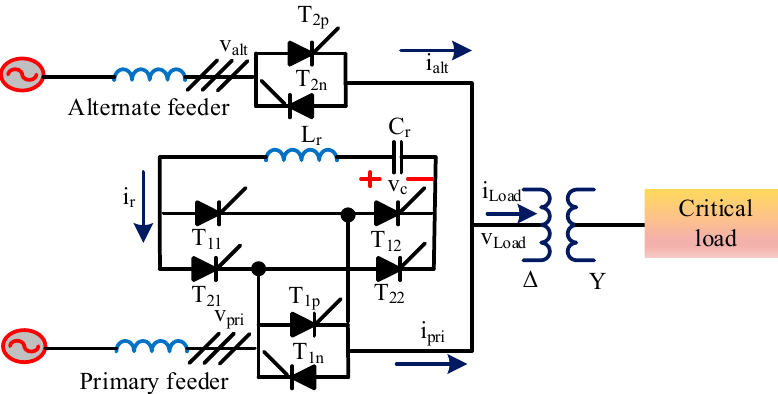
Figure 7. One-line diagram of the ICBSTS system [26].